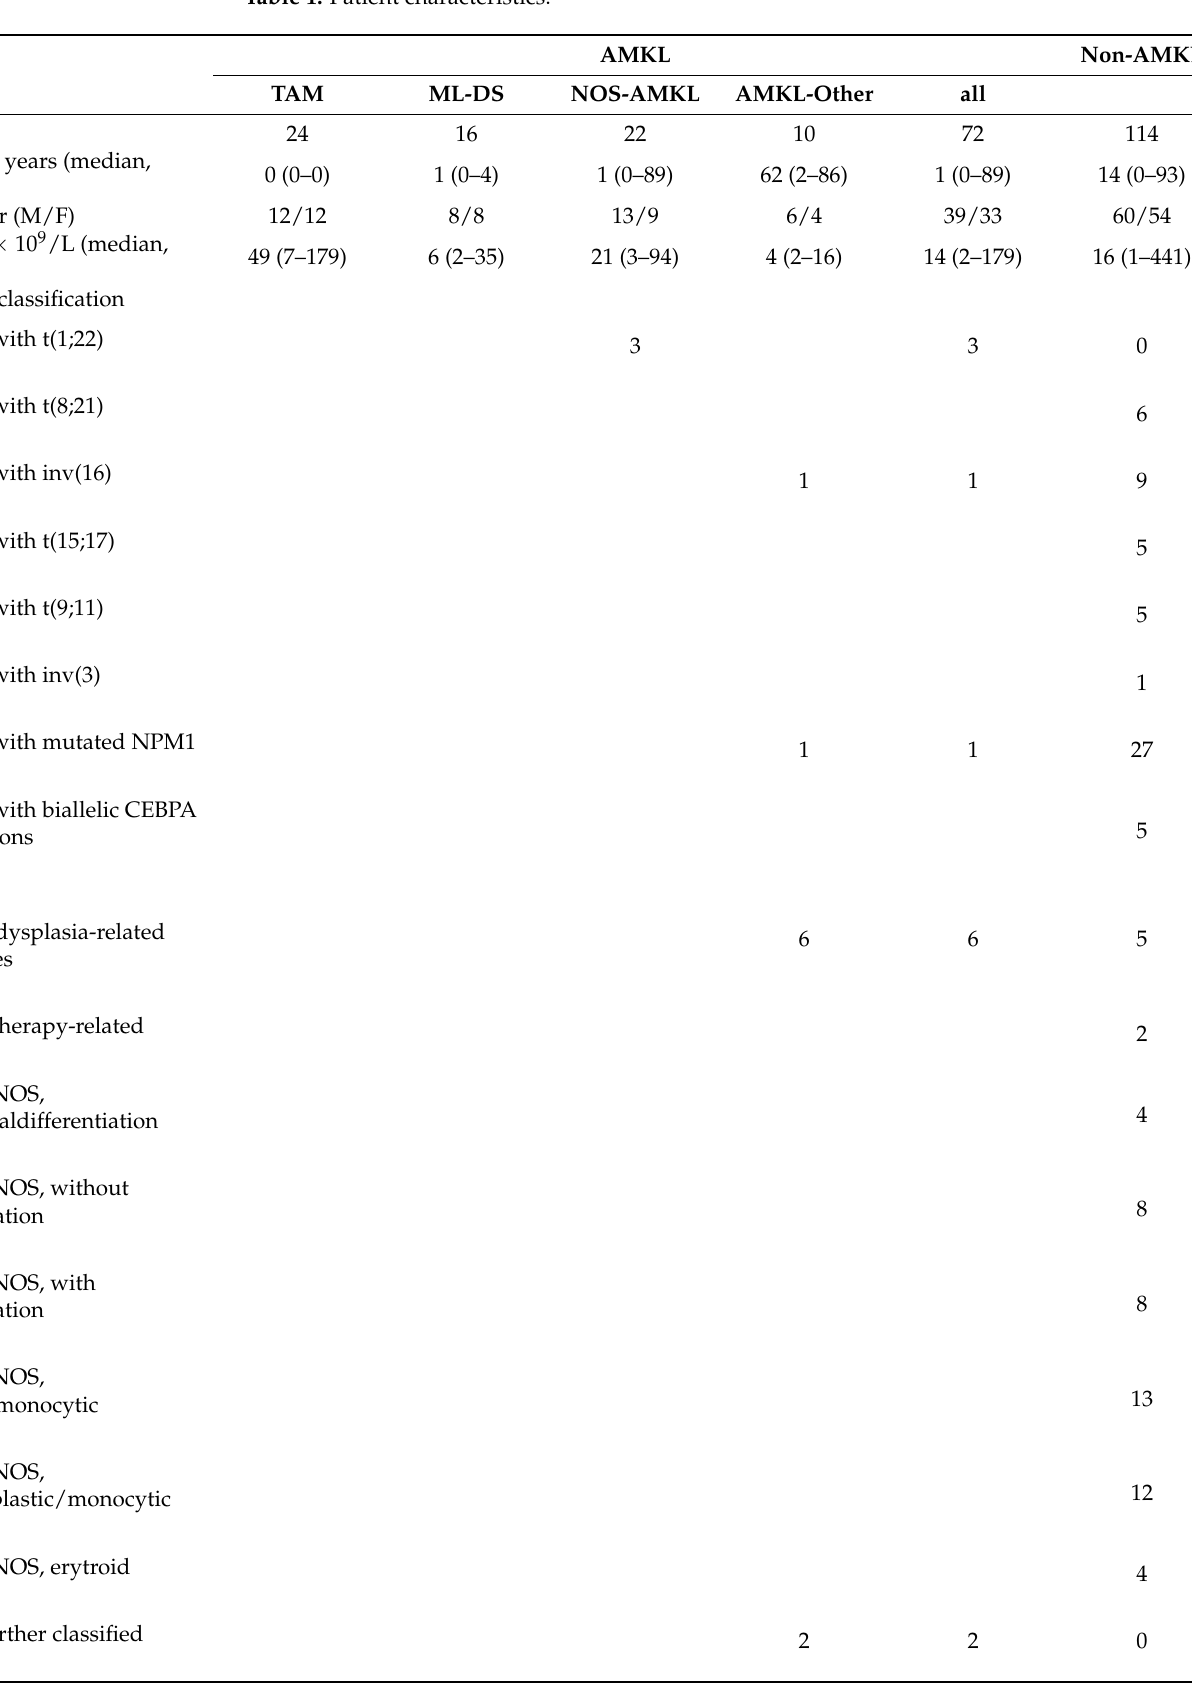
Table 1. Patient